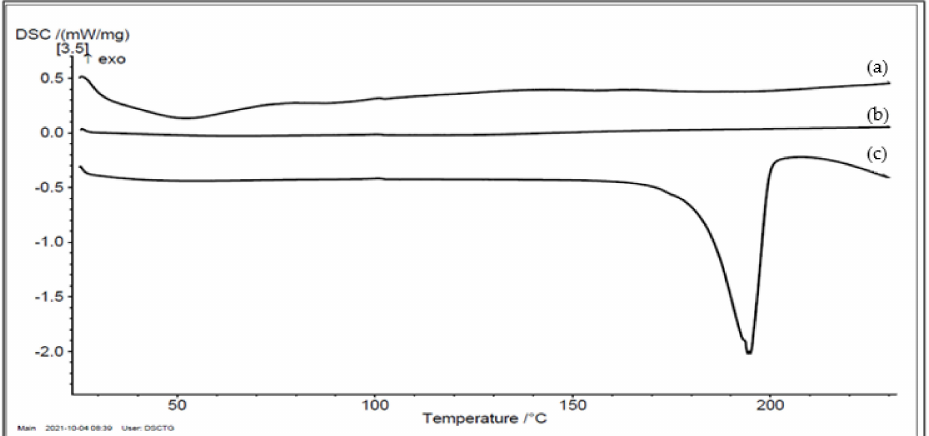
Figure 3. DSC thermograms of (a) PGZ loaded S-SNEDDS, (b) pure SYL and (c) pure PGZ. Abbrevia- tions: DSC, differential scanning calorimetry; SYL, Syloid; S-SNEDDS, solidified self-nanoemulsifying drug delivery system; PGZ, Pioglitazone